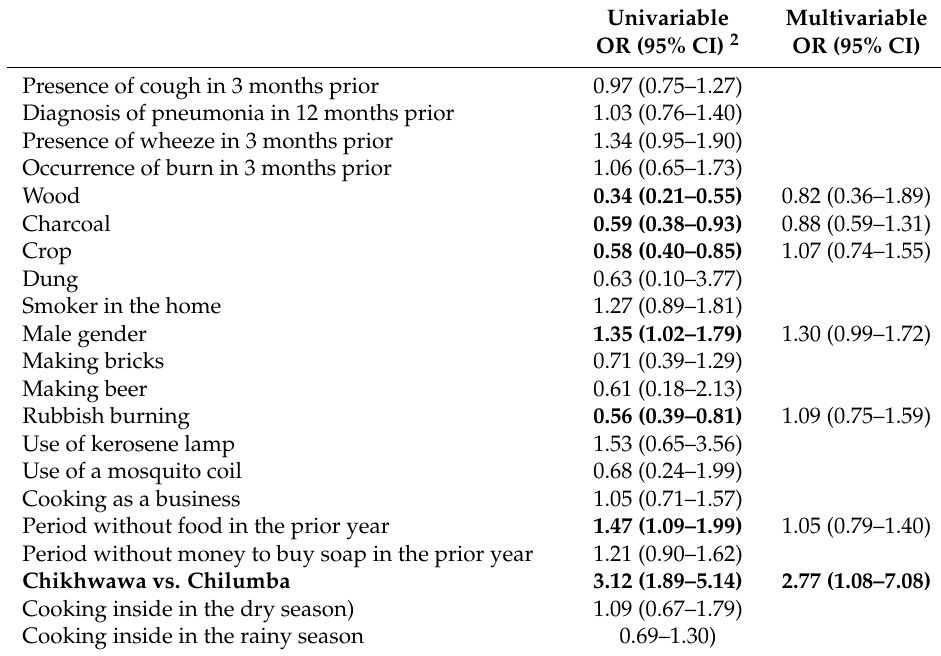
Table 3. Association between household and participant characteristics and elevated carboxyhemoglobin levels ( n = 1520) 1